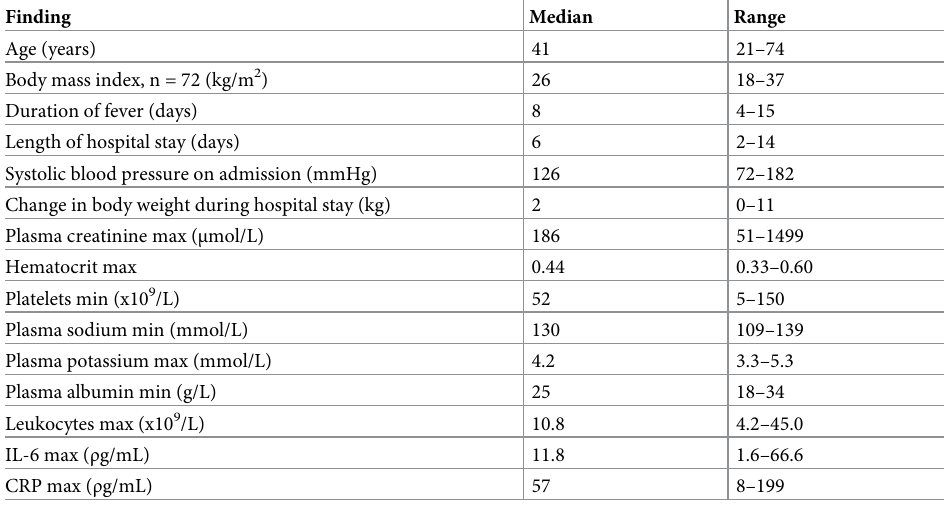
Table 1. Clinical and laboratory findings in 79 patients hospitalized due to acute Puumala hantavirus